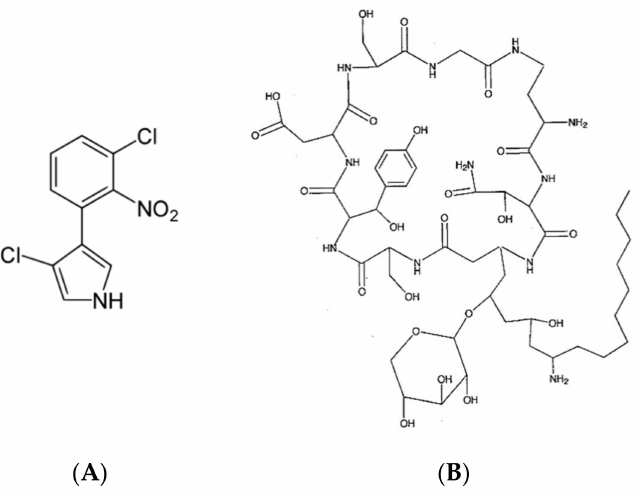
Figure 2. Secondary metabolites produced by Burkholderia cepacia. Where ( A ) 3-chloro-4-(2 (cid:48) nitro- 3 (cid:48) cloro-phenyl) pyrrole pyrolnitrin and ( B ) Cepacidine